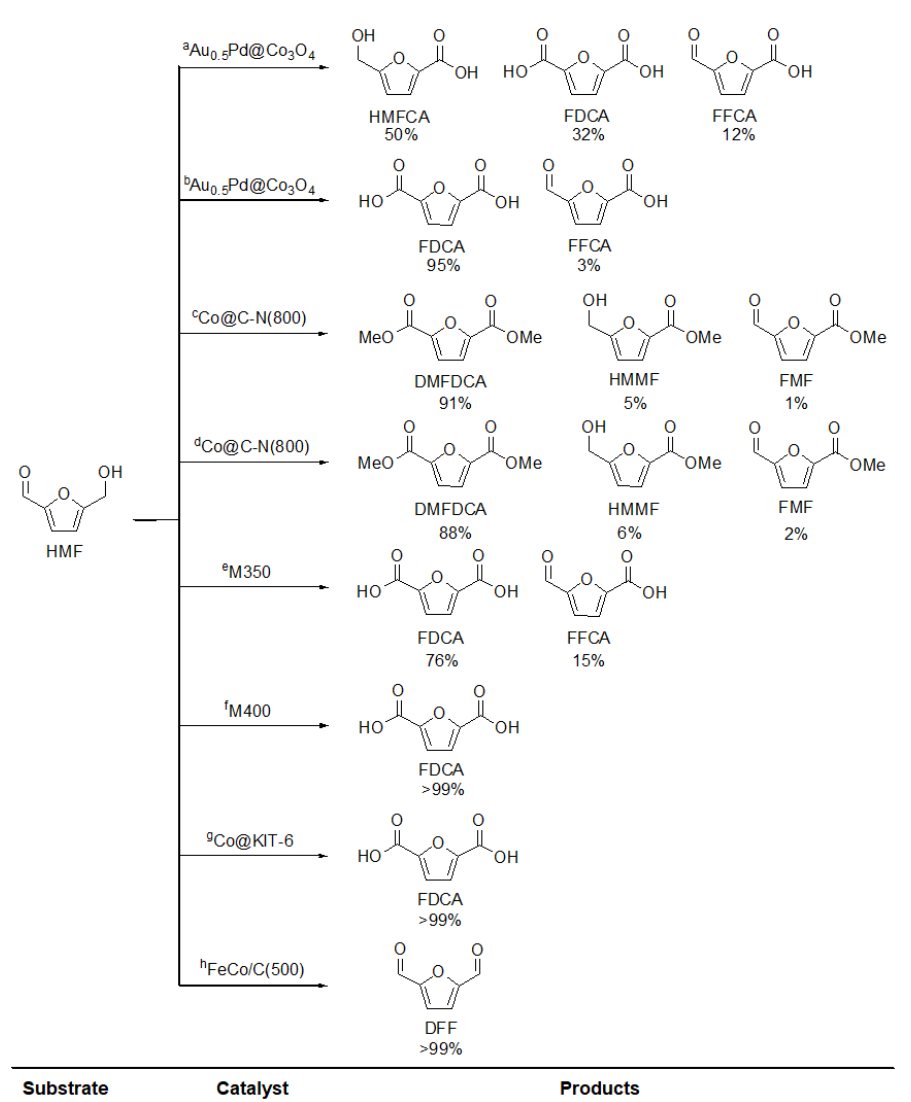
Figure 5. HMF oxidation with different catalysts, synthesized using MOFs as sacrifice